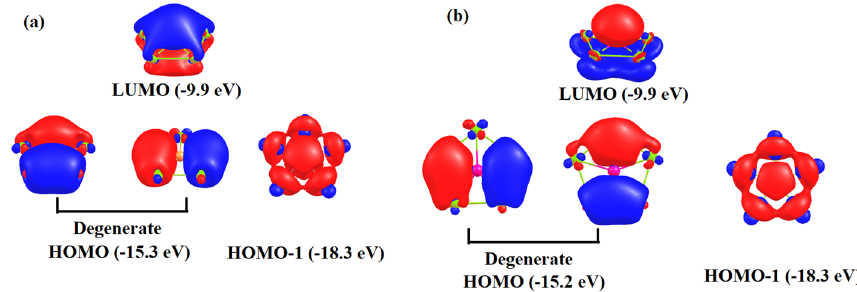
Figure 2. Frontier Kohn–Sham orbitals of ( a ) Cu 5 Al 2+ and ( b ) Cu 5 Ga 2+ . Contour value used was 0.03 au.